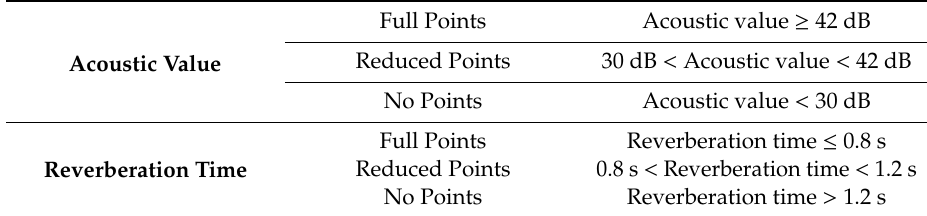
Table 5. Score for the subcategory “Acoustic